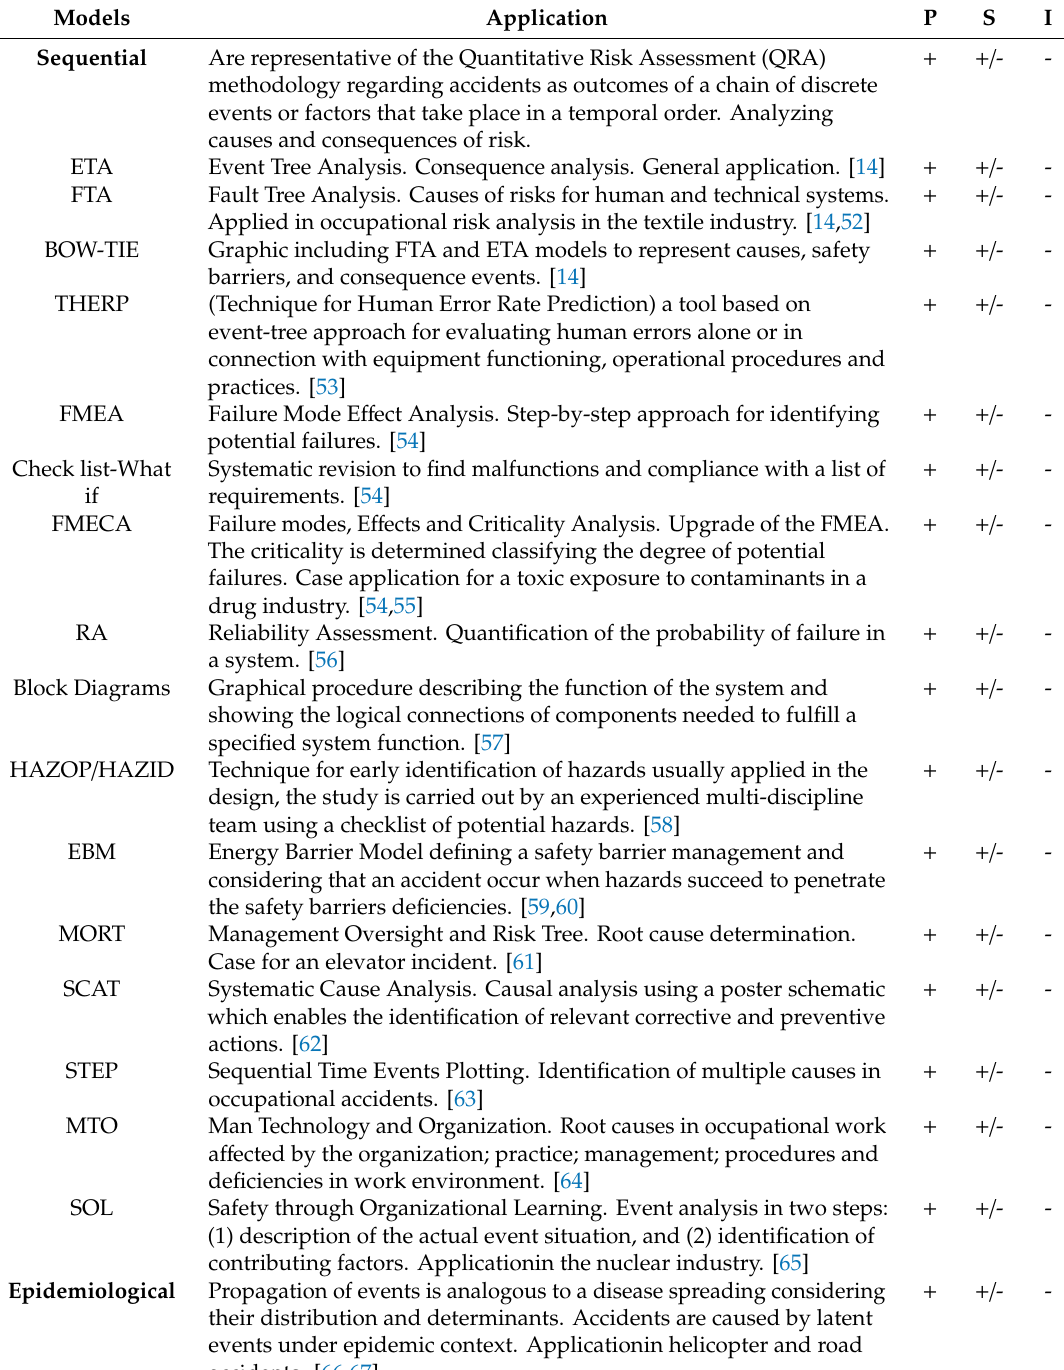
Table 2. Existing traditional